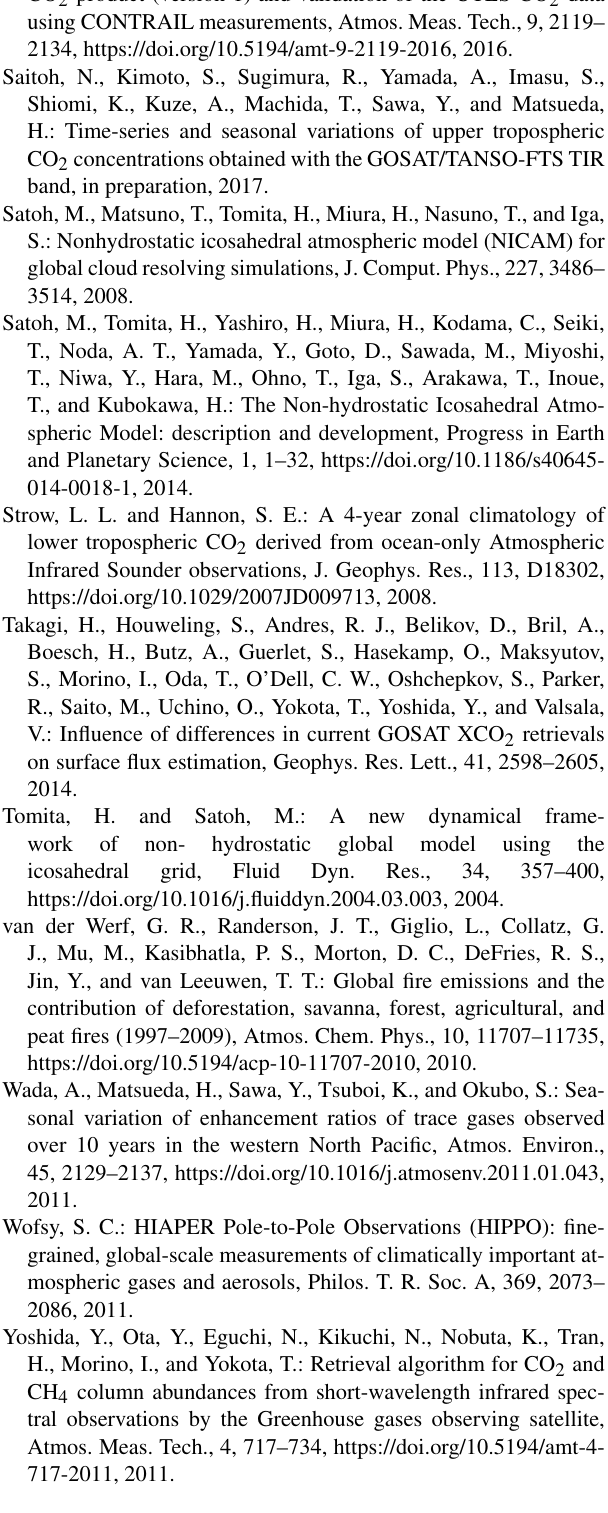
Algorithm update of the GOSAT/TANSO-FTS thermal